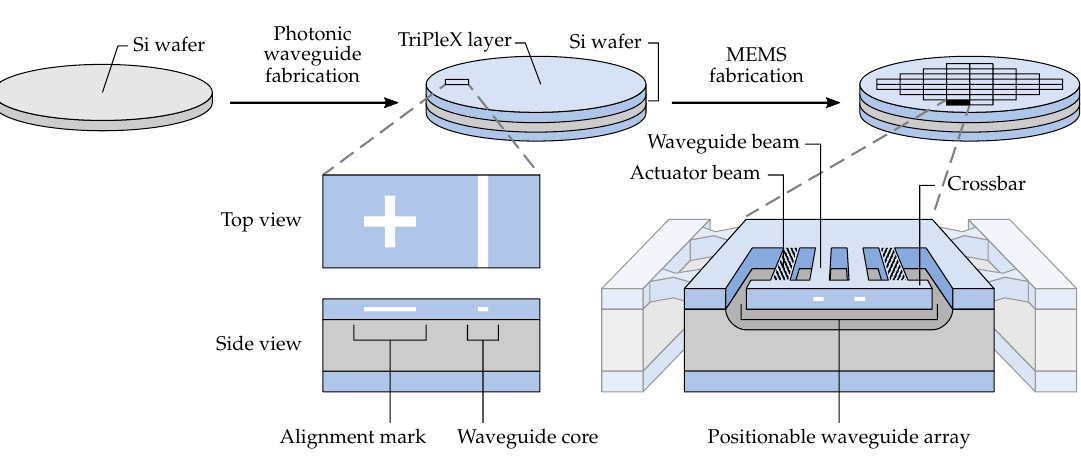
Figure 4. The two consecutive sequences for the fabrication of positionable waveguide arrays. First, photonic waveguide functionality is created. After that, MEMS functionality is